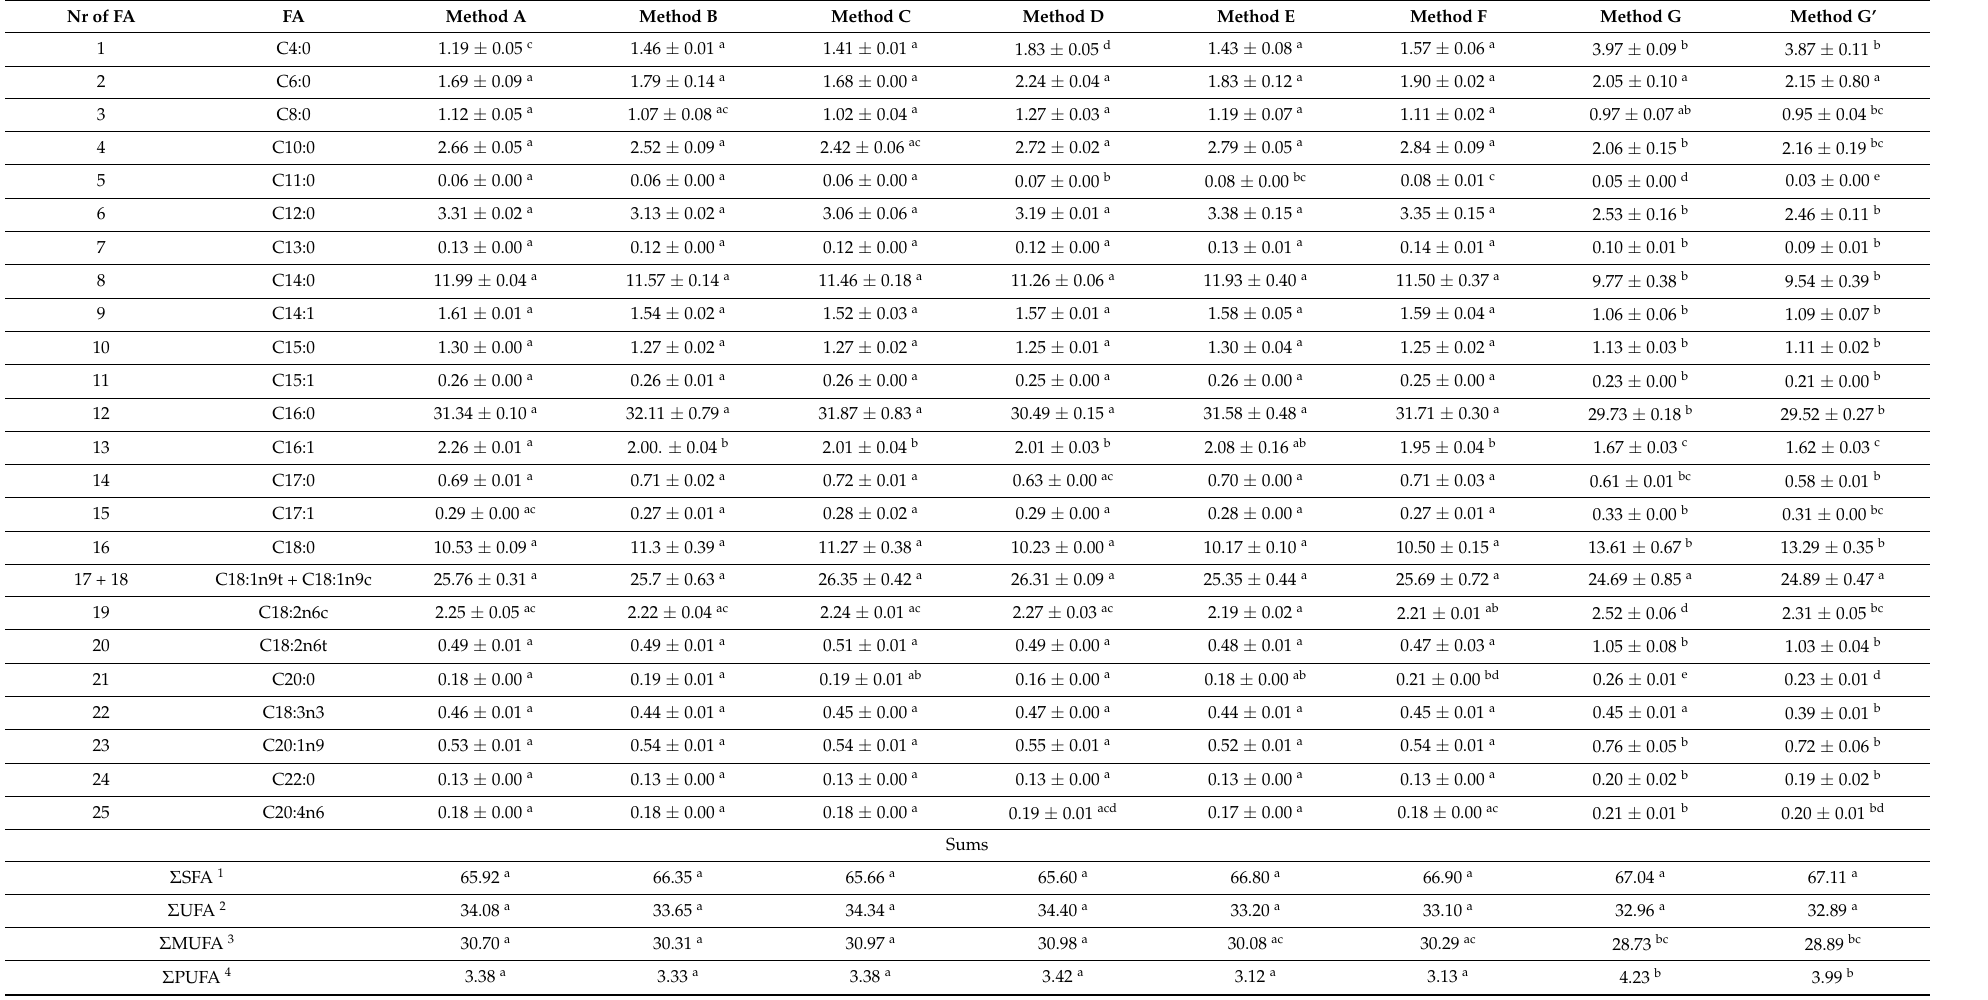
Table 2. Fatty acid compositions of cow milk. Data are expressed as total mean (g/100 g FA) ± standard deviation of